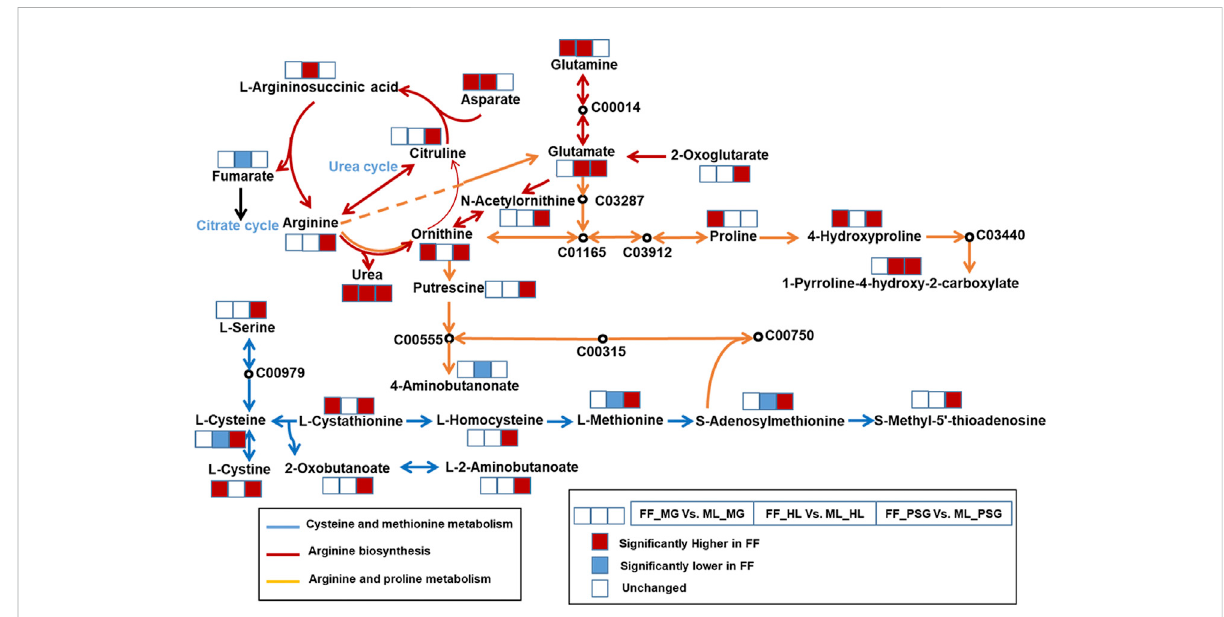
The integrated mutual metabolic pathways in the midgut (MG), hemolymph (HL) and posterior silk gland (PSG) of the formula feed (FF) silkworms. The blue, red and yellow line represented different metabolic pathways. The KEGG ID represented those were not detected or were not signi fi cantly different between the FF and mulberry leaves (ML) fed silkworms. The three squares with colors showed the different trends of metabolitesintheMG,HLandPSG,respectively.Thered,blueandblanksquaresrepresentedthemetabolitesweresigni fi cantlyhigher,loweror unchanged in the FF group,